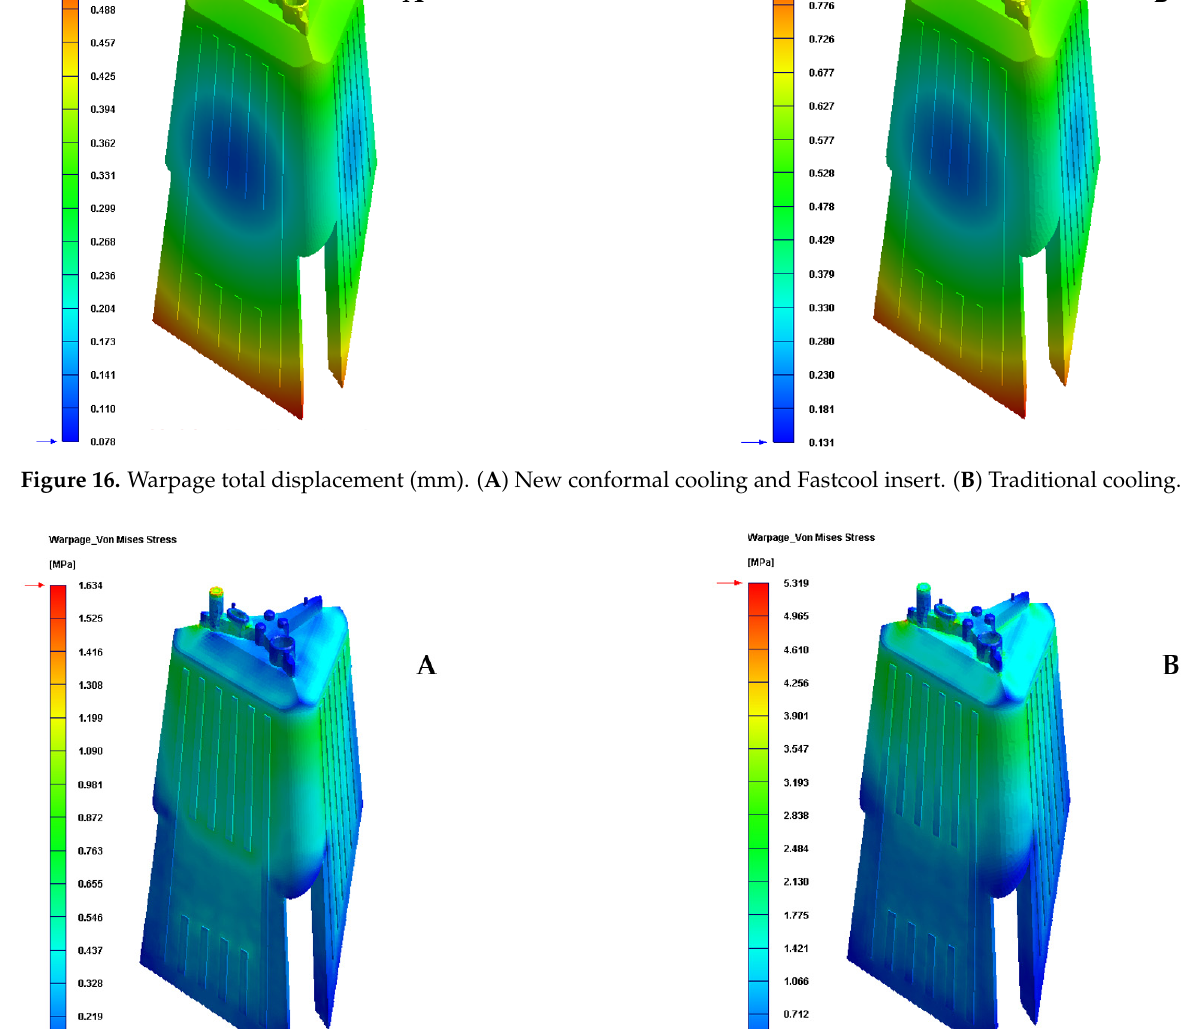
Figure 17. Warpage Von—Mises stress (MPa). ( A ) New conformal cooling system and Fastcool insert. ( B ) Traditional cooling.